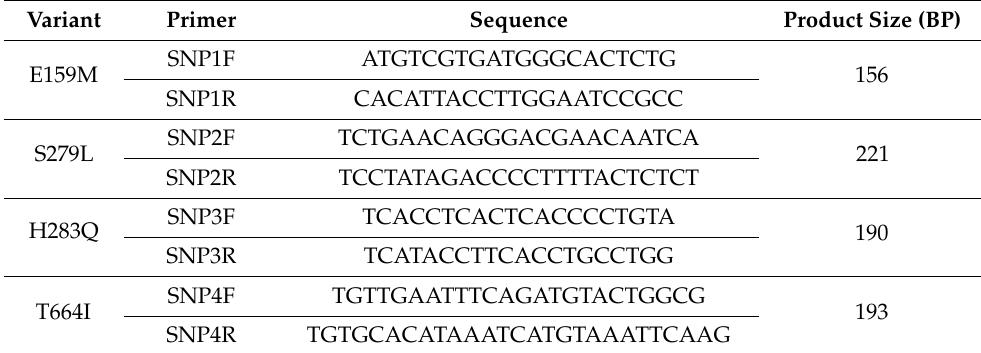
Table 2. Primer Pair Sequences Used to Amplify ABCG2